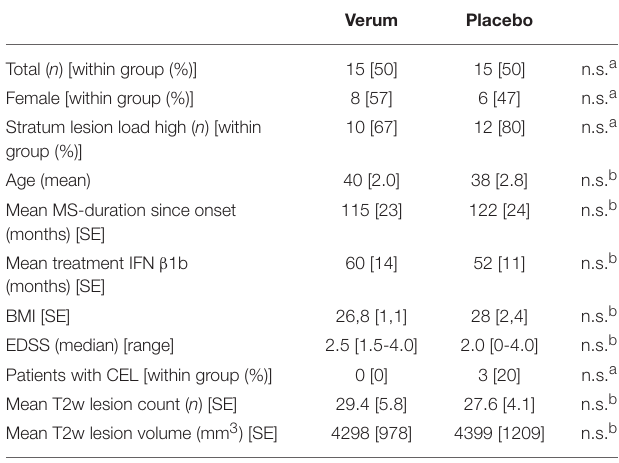
TABLE 1 | Patients characteristics and baseline data.